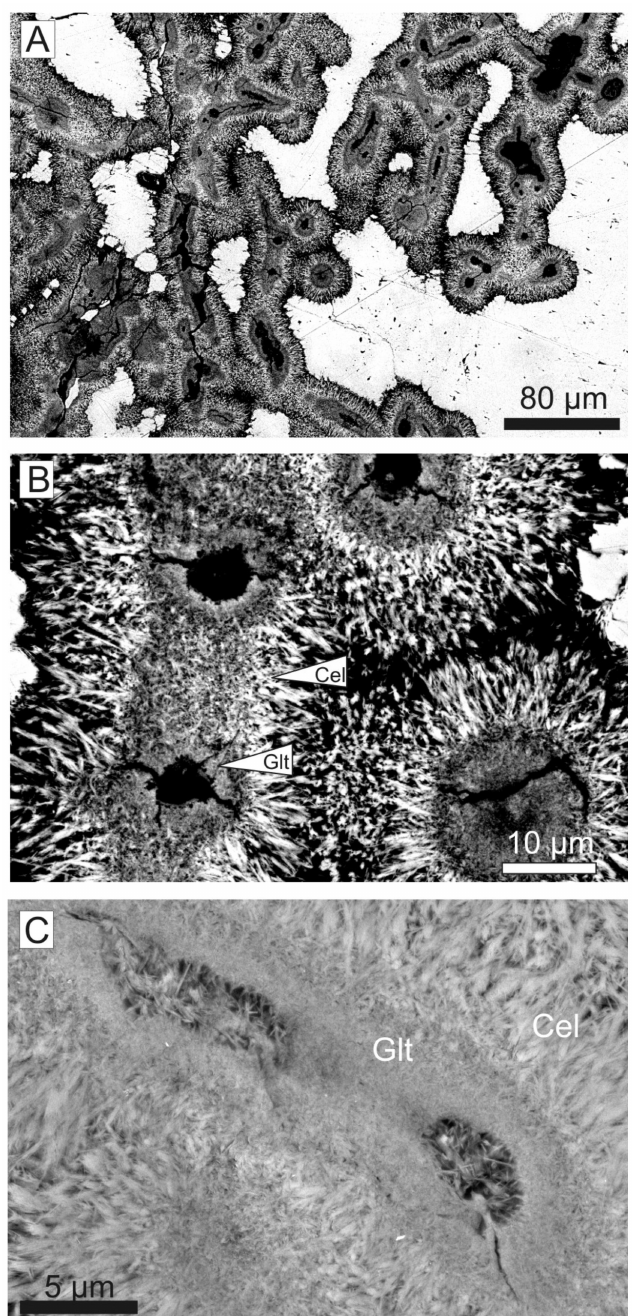
Figure 19. Filaments composing the green laminated crusts observed under SEM-BSE. ( A ) General view of filaments with transversal and longitudinal sections. ( B , C ) Detailed views of the filaments with differentiation of three parts, with the inner one being a void, the intermediate one homogeneous glauconite (arrow Glt), and the outer one composed by needle-like crystals of celadonite (arrow